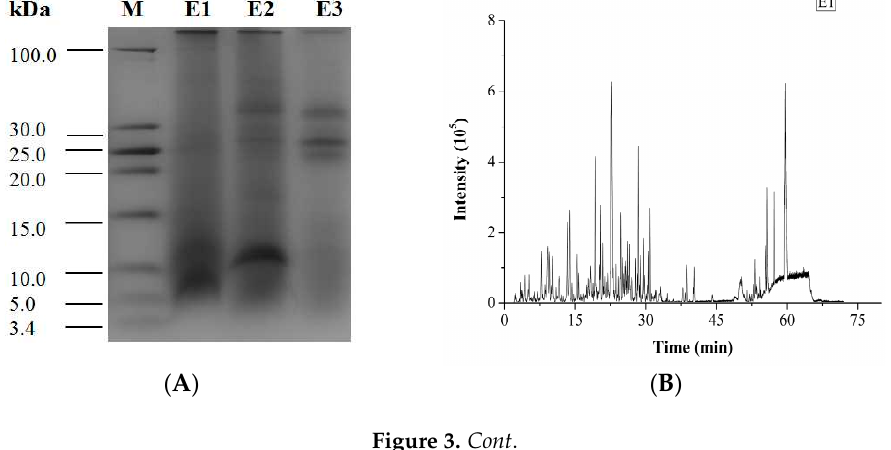
Figure 2. The degree of hydrolysis of M. edulis proteins from different fractions was shown. Values designated by different letters (a,b) are considered statistically different ( p < 0.05). All statistical tests ( n = 3) were conducted using SPSS software 19.0 (SPSS Inc., Chicago, IL, USA).